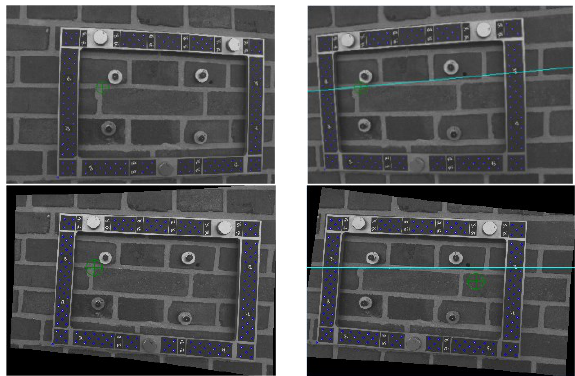
Figure 8: Original and normalized stereo images